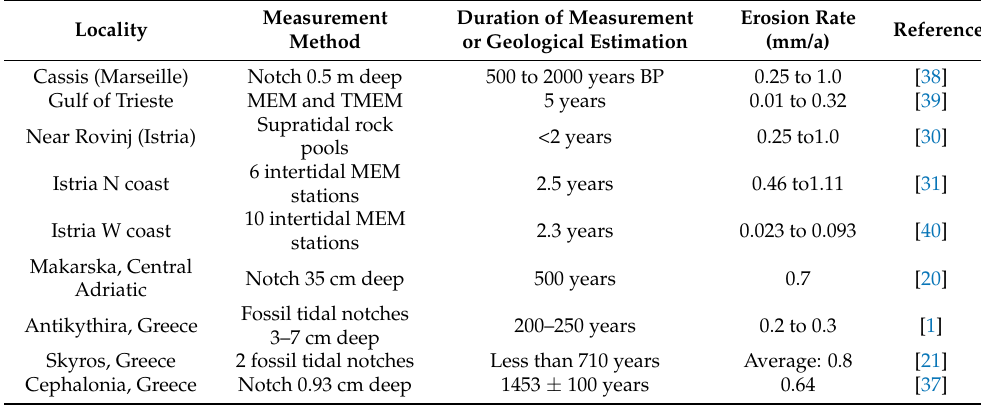
Table 1. Measured erosion rates on carbonate coastal rocks at Mediterranean sites (MEM is for micro-erosion metre and TMEM for traversing micro-erosion